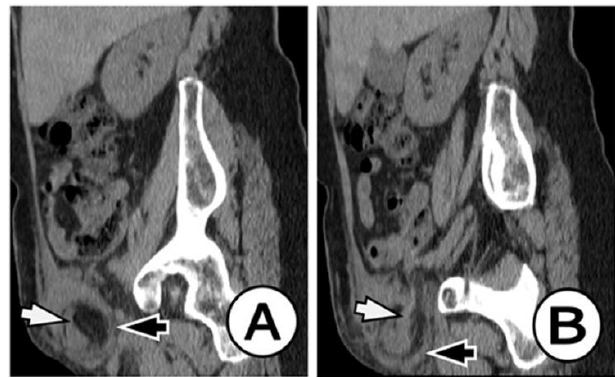
Figure 2: Sagittal reformatted CT image of the abdomen: Sagittal reformatted CT image shows an inflamed appendix (white arrow) extends into the small right inguinal hernia (black arrow). There were no signs of obstruction or